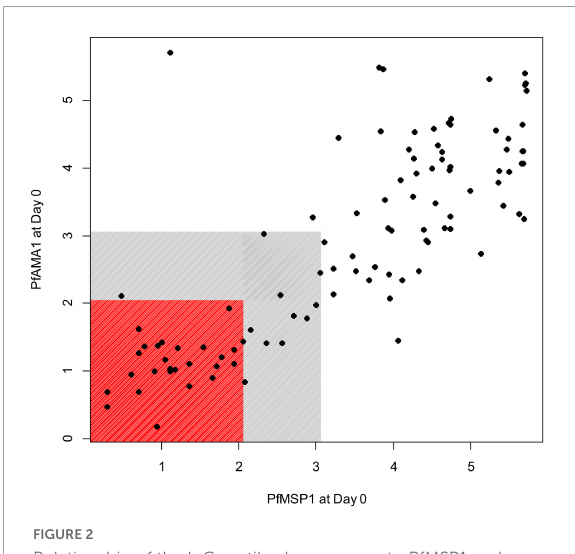
FIGURE2 Relationship of the IgG 1 antibody responses to PfMSP1 and PfAMA1 at the first day of follow-up (Day 0) in children treated for P. falciparum infection. Axes display assay log 10 -transformed assay signal to the two respective P. falciparum antigens. Children IgG 1 seronegative for both antigens are shown by markers in the red box, and children nominally IgG 1 seropositive to either (or both) antigens shown in gray box. Children seronegative to both targets are classified as P. falciparum naïve, and children with assay signals greater than the gray shading classified as non-naïve.